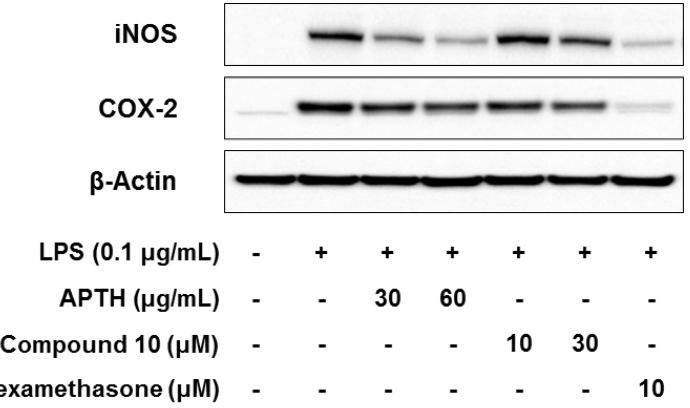
Figure 3. Effects of APTH and compound 10 on iNOS and COX-2 expression in LPS-induced RAW264.7 cells. Cells were pretreated for 1 h in the presence or absence of samples and then treated for 16 h with LPS (0.1 μ g/mL). The iNOS and COX-2 protein expression levels were detected by Western blot analysis, and β -actin was used as the loading control. Dexamethasone served as the positive control.